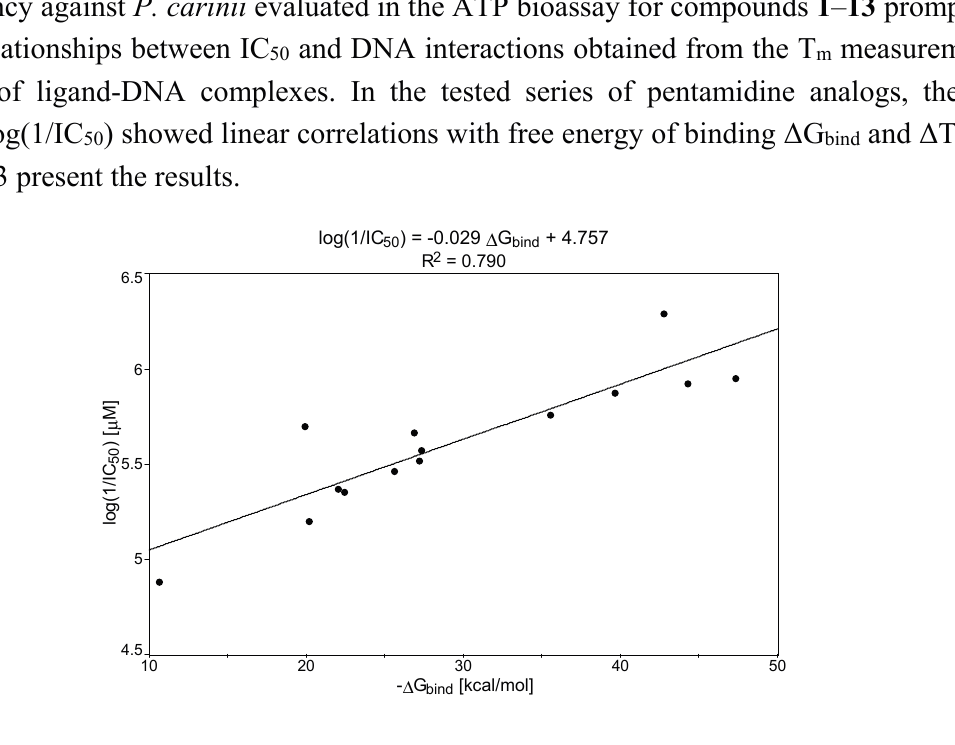
Figure 2. The plot of log(1/IC 50 ) versus theoretically estimated DNA free energy of binding ( − Δ G bind ). The obtained equation for log(1/IC 50 ) vs. ( Δ G bind ) was log(1/IC 50 ) = − 0.029 Δ G bind + 4.757 (R 2 = 0.790), and for log(1/IC 50 ) vs. Δ T m , was log(1/IC 50 ) = 0.195 Δ T m + 5.084 (R 2 = 0.728). These correlations (the